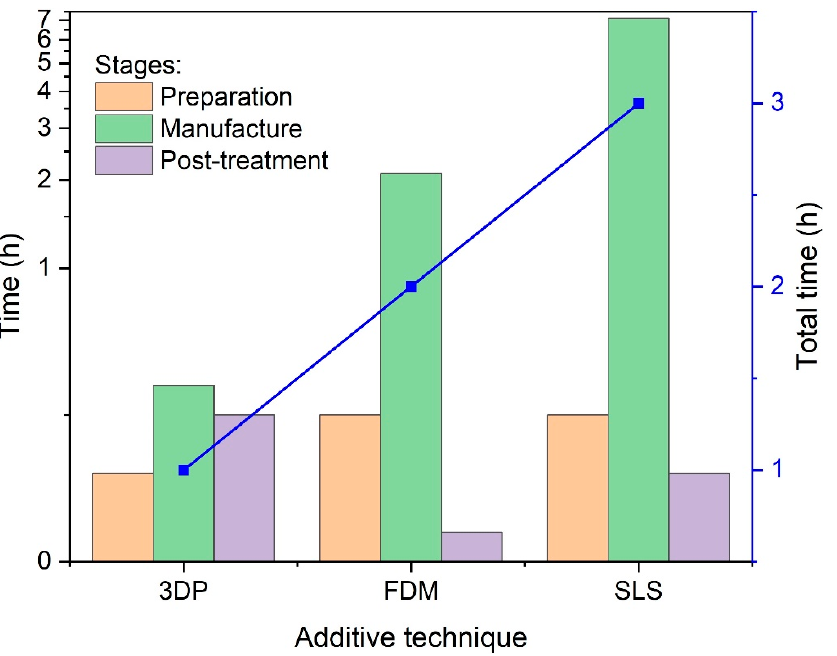
Figure 9. Comparison of the time at stages (preparation-manufacture-post-treatment) and the total time of pulley production using 3DP, FDM and SLS techniques.